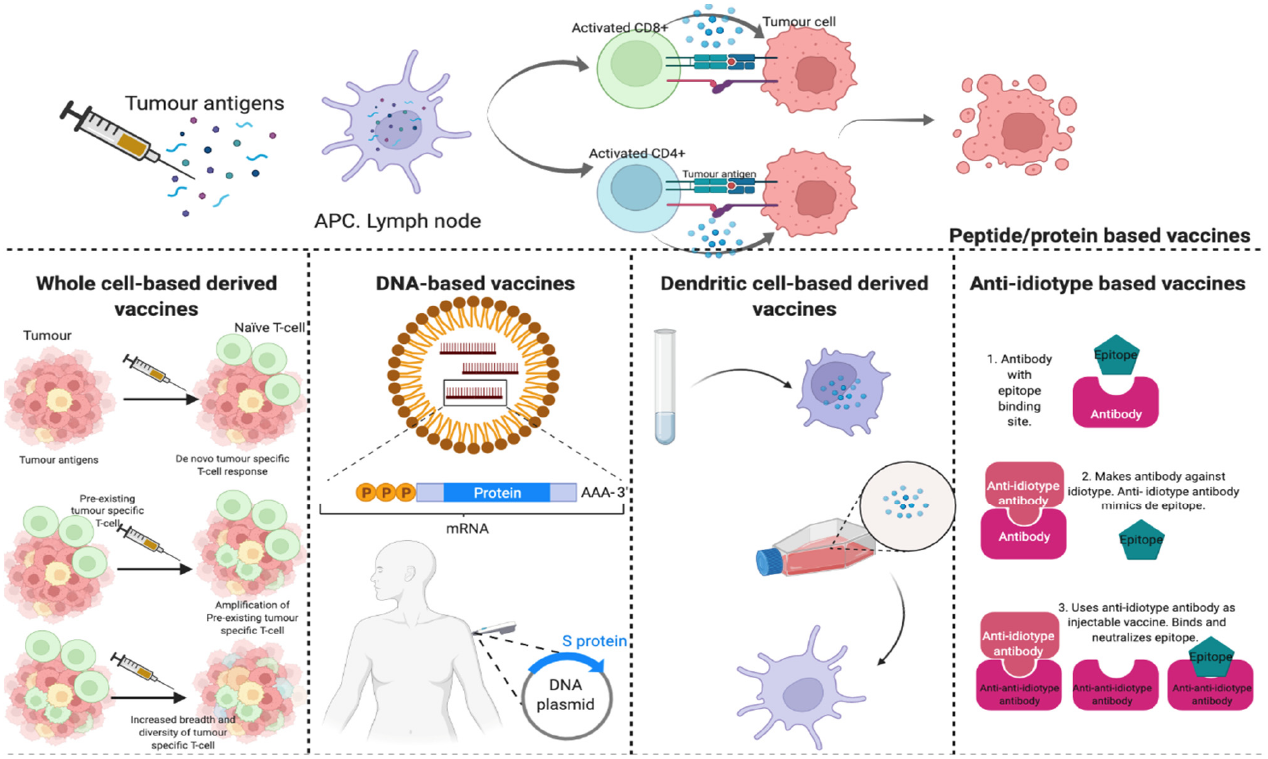
Figure 2. Different vaccination models harbouring HER2+ tumours. APC: Antigen-presenting cell. Table 3. Published clinical trials with HER2+ breast cancer patients treated with anti-HER2 vaccines. PUBLISHED